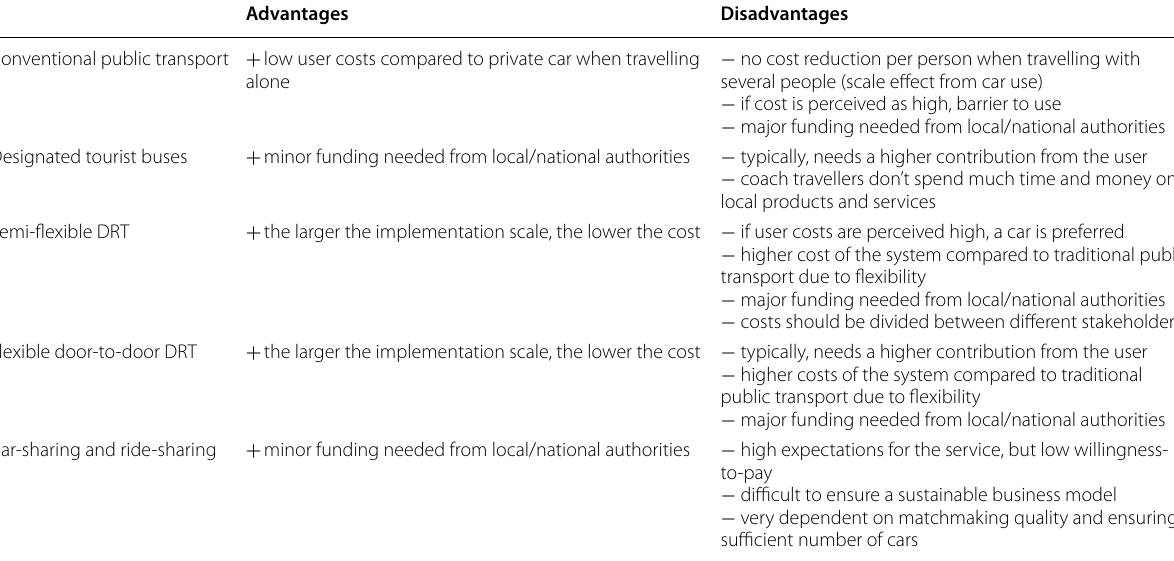
Composed based on Baker [68], Mullay and Nelson [78], de Jong et al. [10], Pronello and Camusso [76], Guyader and Piscicelli [77], Cottrill et al. [1], Panzer-Krause [42], Porru et al. [12], SMARTA [52] and Lygnerud and Nilsson